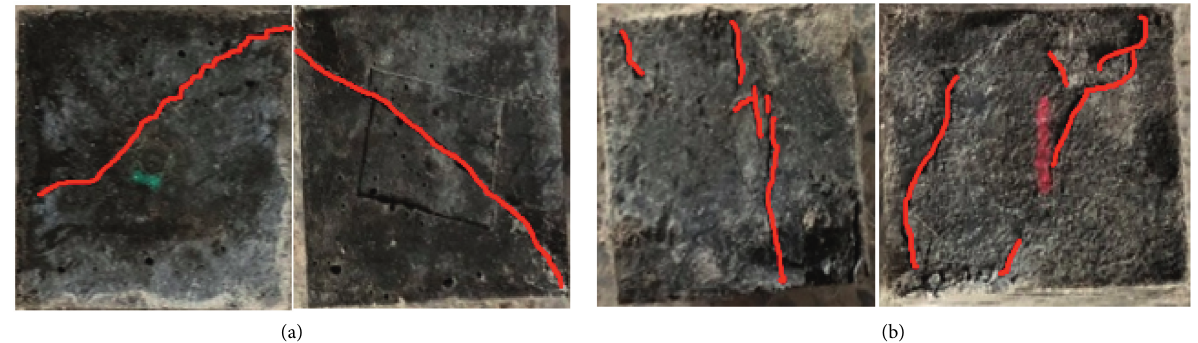
Figure 3: Damage mode of PFCBCM (a) without polyurethane and (b) with polyurethane.